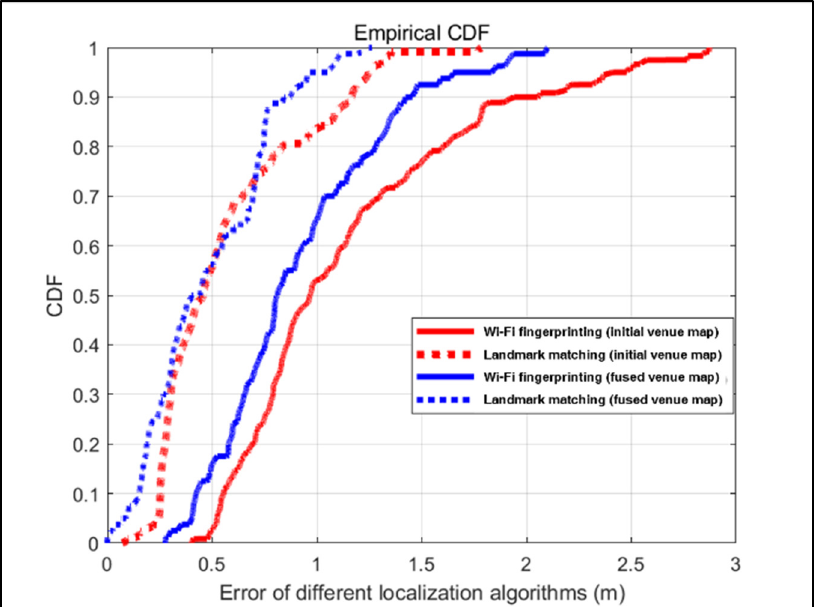
Figure 12. CDF of the location estimation error for the shopping mall scene.